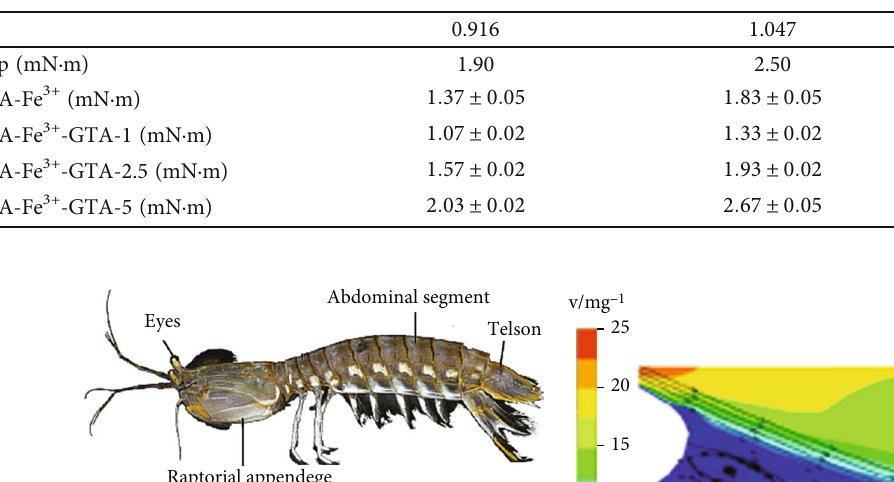
Table 1: Torque values of the control group and the coating group at di ff erent speeds [53].